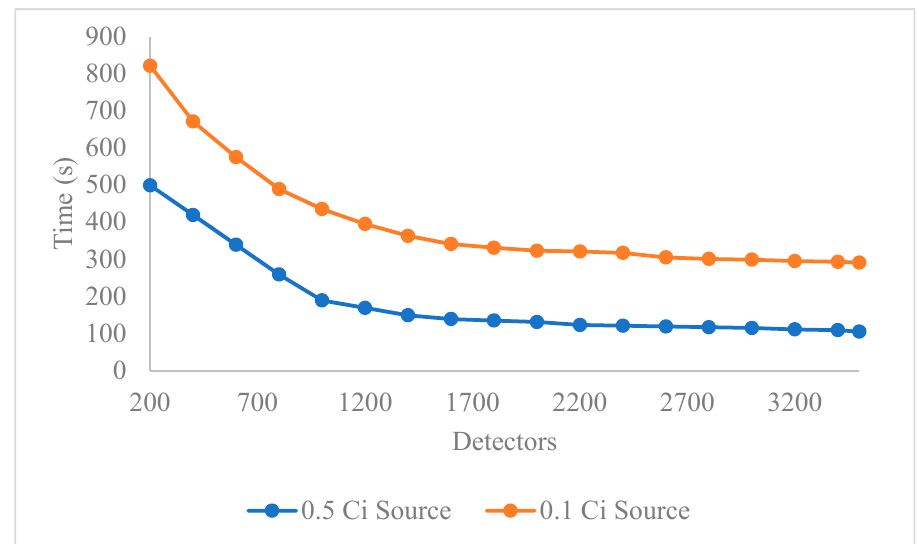
Figure 5. The average time of first detection from the start of the source routes. This calculation was done for sources moving at 10 m/s.